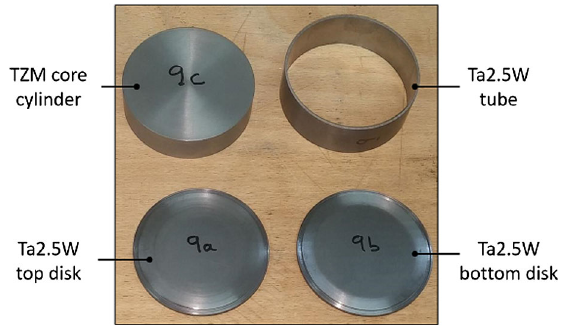
FIG. 3. View of the refractory metal parts required for the production of a Ta2.5W-clad TZM target block (80 mm diameter, 25 mm length) for the BDF target